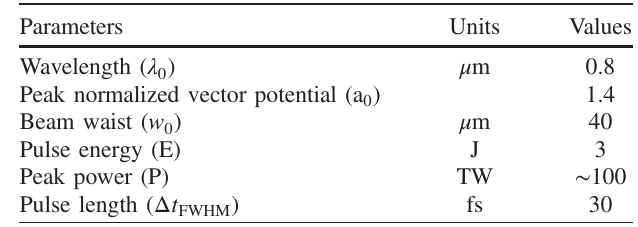
TABLE II. Key parameters for the laser setup.